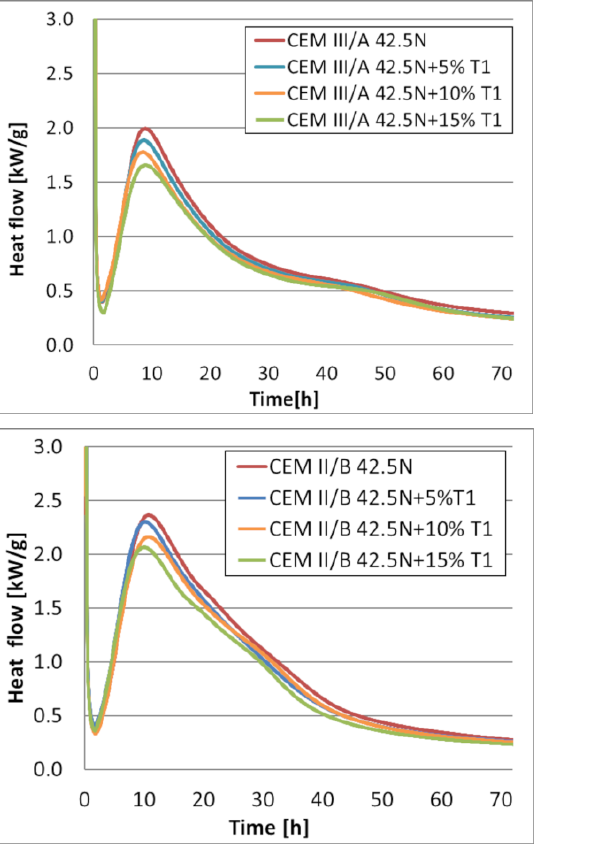
Figure 7. The ratio of the total heat of the slag-limestone cement hydration after 72 h to the weight content of slag cement in multi-component slag-lime cements with ( a ) CEM II/A-S 42.5N, ( b ) CEM II/B-S 42.5N, ( c ) CEM III/A 42.5N cement.